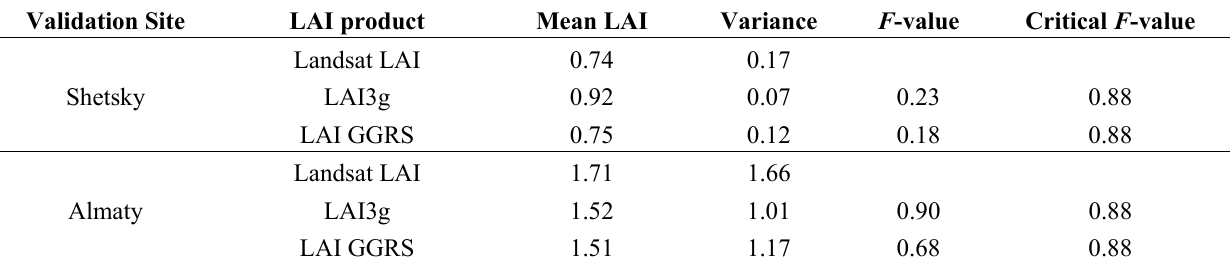
Table 5. Test statistics and results of the F -test conducted for a comparison of the LAI3g and the LAI GGRS product versus the ground-based up-scaled Landsat LAI. The null hypothesis of variance equality is accepted when F -value < critical F